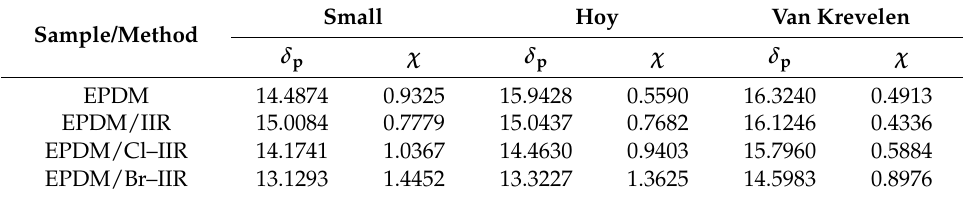
Table 4. Values of solubility parameters and of polymer–solvent interaction